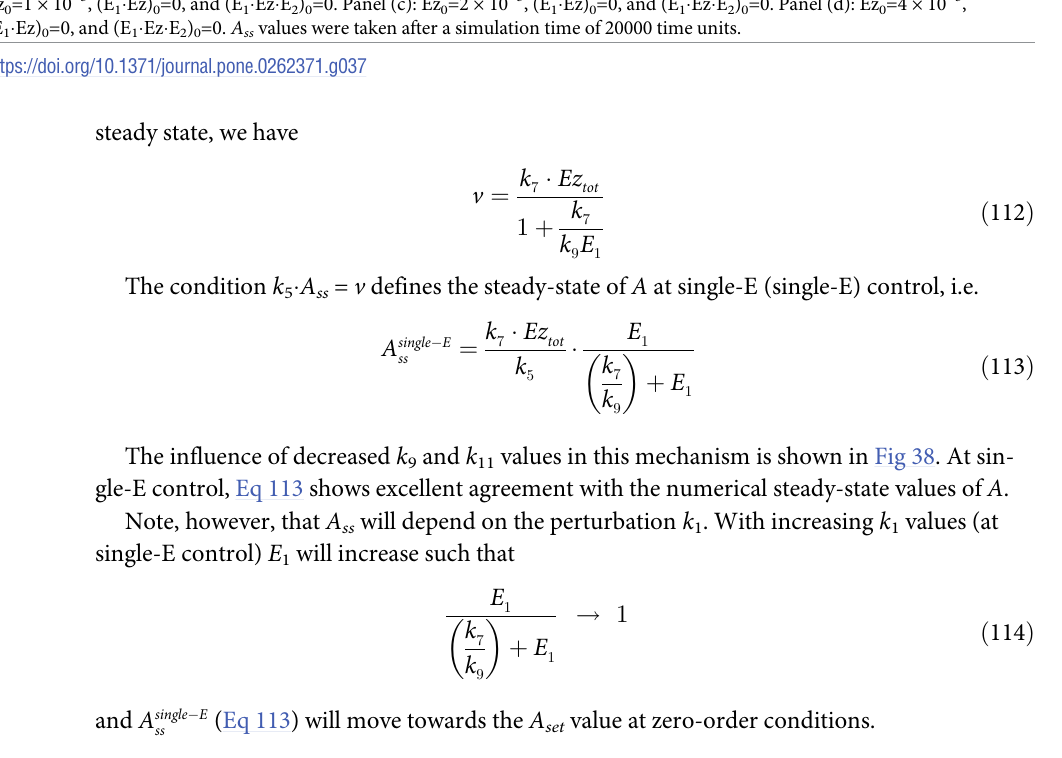
value at zero-order conditions. set